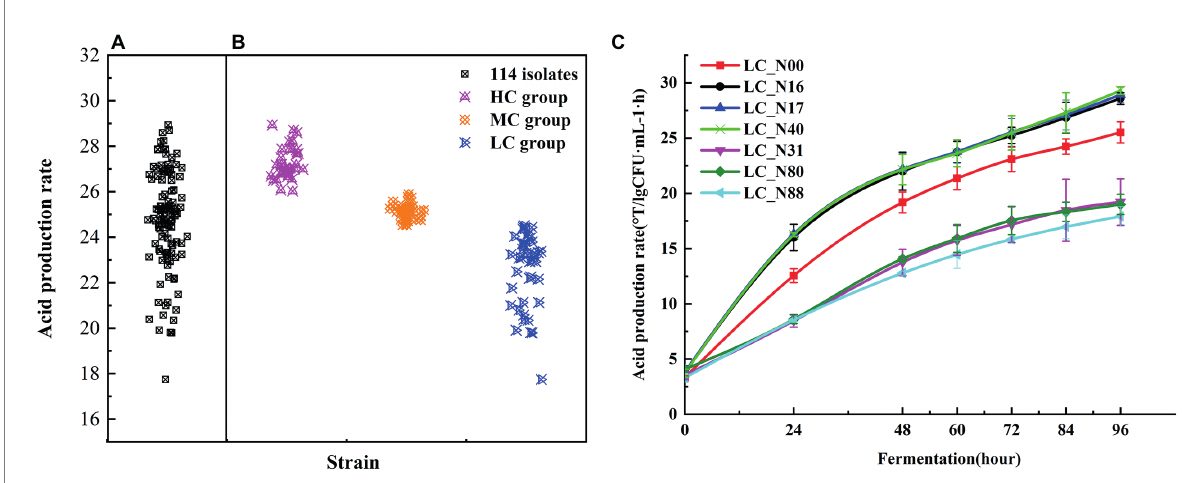
FIGURE 1 Acid production rate of L. casei . (A) Acid production rate of 114 isolates fermented for 96 h. (B) Acid production rate of HC, MC, and LC strains. (C) Acid production rate of representative strains from the HC (LC_N16, 17, 40) and LC (LC_N31, 80, 88) groups, up to 96 h, compared with the commercial strain LC_N00. Tests were performed in triplicate and were expressed as means ± SD. Analysis of variance (ANOVA) was performed by Tukey’s test for pairwise comparison.